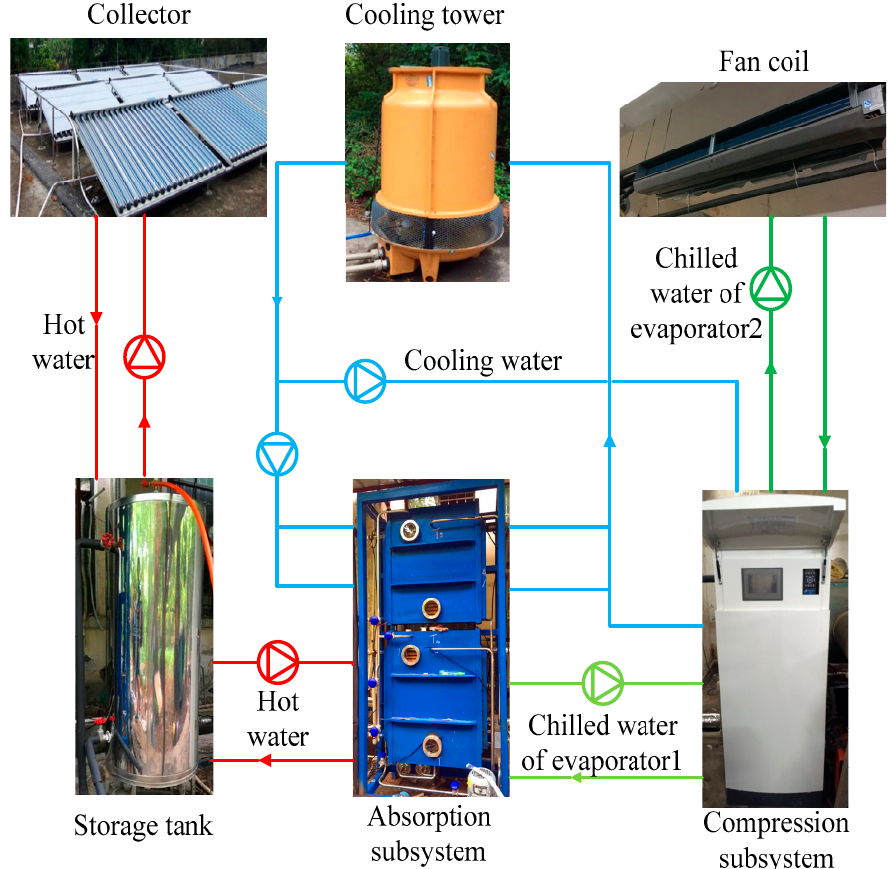
Figure 1. Picture of prototype.